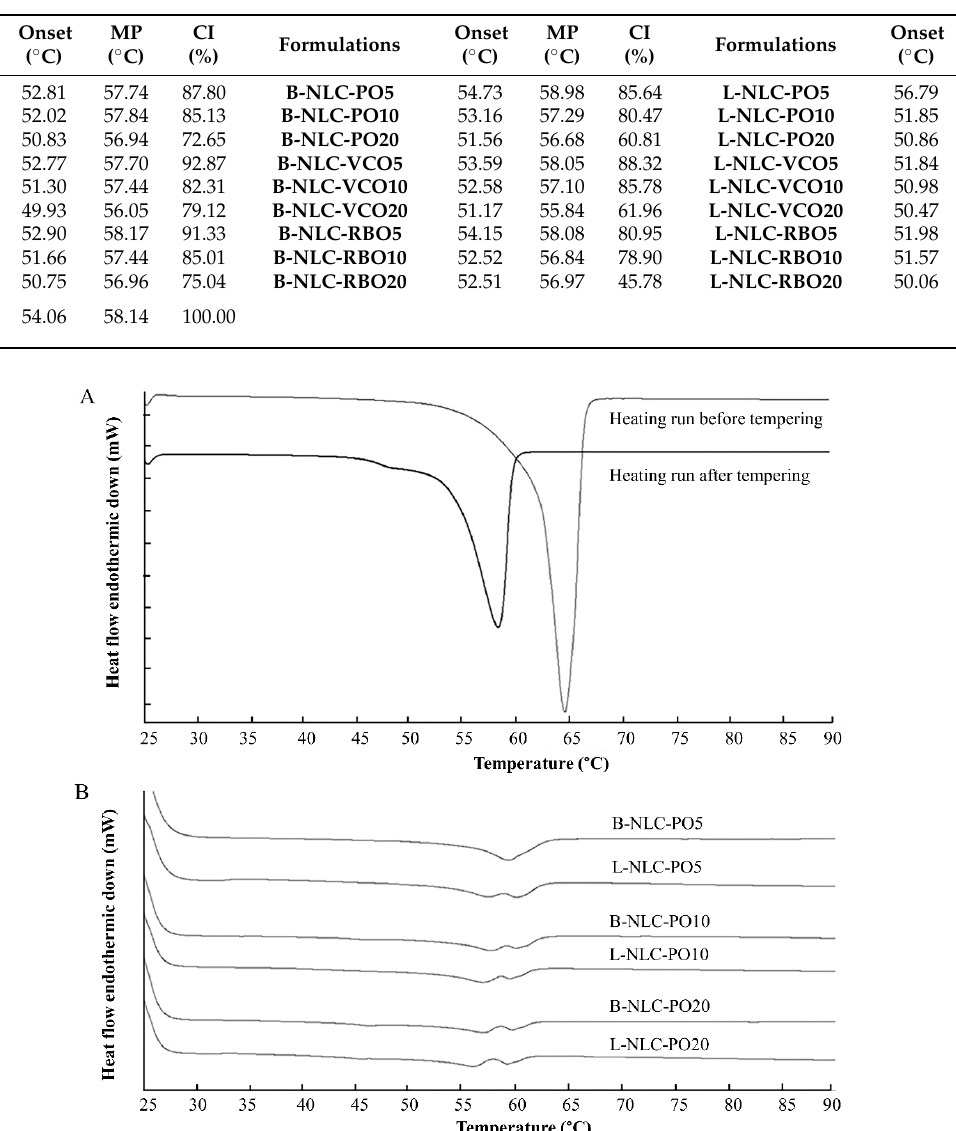
Figure 3. DSC thermograms of GMS before and after tempering at 90°C for 15 min ( A ); a B-NLC and L-NLC containing 5, 10 and 20% of PO loading ( B ). Table 3. The onset, melting endotherm and %CI of physical mixtures of GMS and vegetable oils at different ratios, lutein-free and lutein-load nanocarriers, and bulk GMS after tempering .